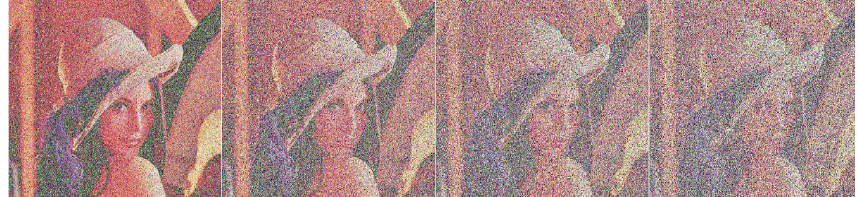
Figure 11. Decrypt images after different salt-and-pepper noise was added to cipher